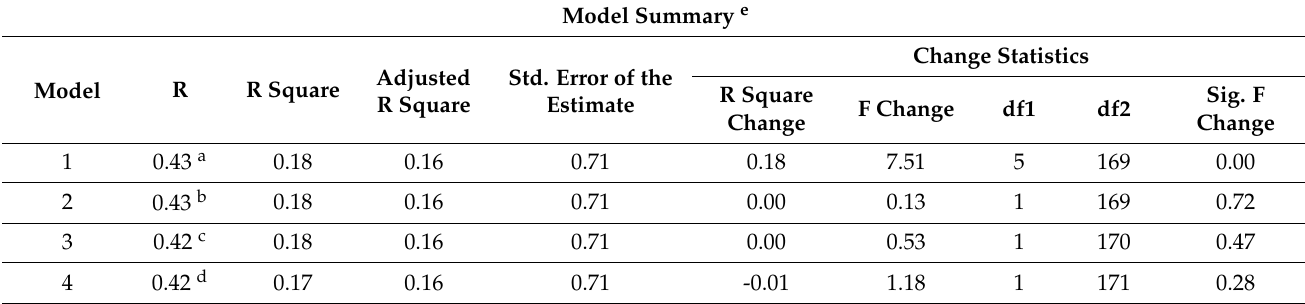
Table 7. Multiple linear regression model summary.